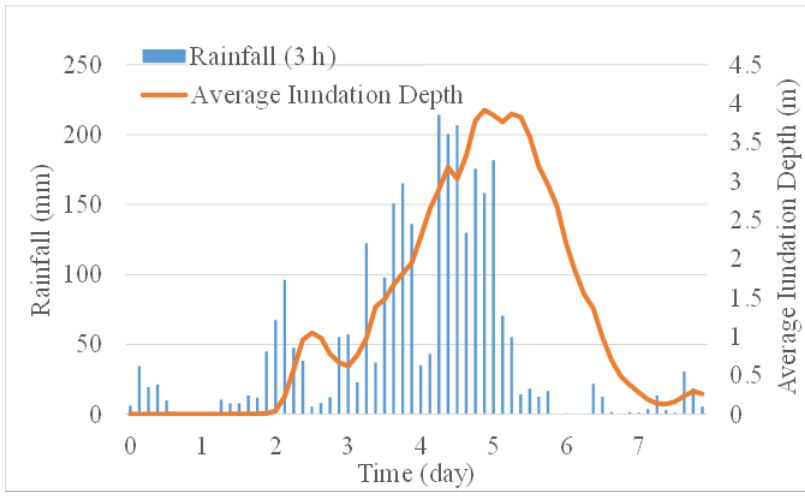
Figure 2. Rainfall histogram and average inundation depth hydrograph for Event 7.